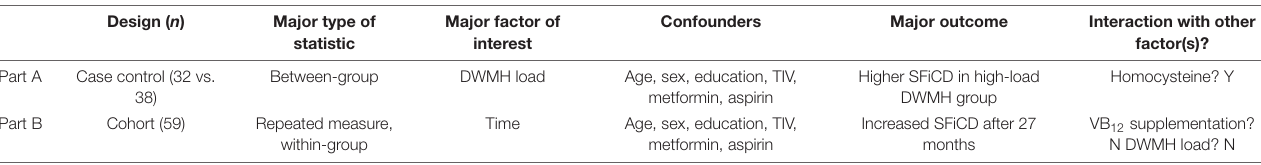
TABLE 2 | Overview of the results of the analyses of cross-sectional (Part A) and longitudinal data (Part B). Design ( n